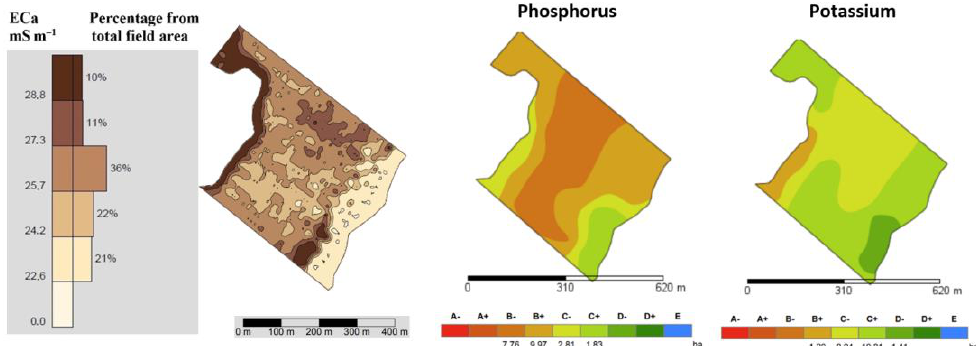
Figure 1. Mapping ECa, phosphorus, and potassium in the soil of experimental field. After evaluating nitrogen uptake, which varied from 7.3% to 25.1% in the studied field, it was determined that the fertilization rate should vary from 42.3 to 90.3 kg N ha −1 (Figure 2).